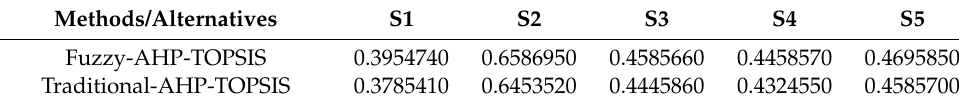
Table 19. Comparison of the results of classical and fuzzy AHP-TOPSIS methods .